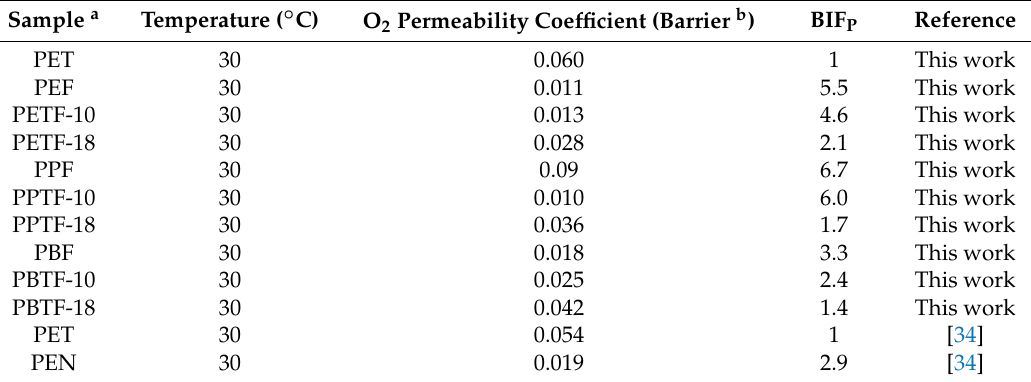
Table 6. O 2 barrier properties of PEF, PPF, PBF, and the copolyesters modified with CBDO.